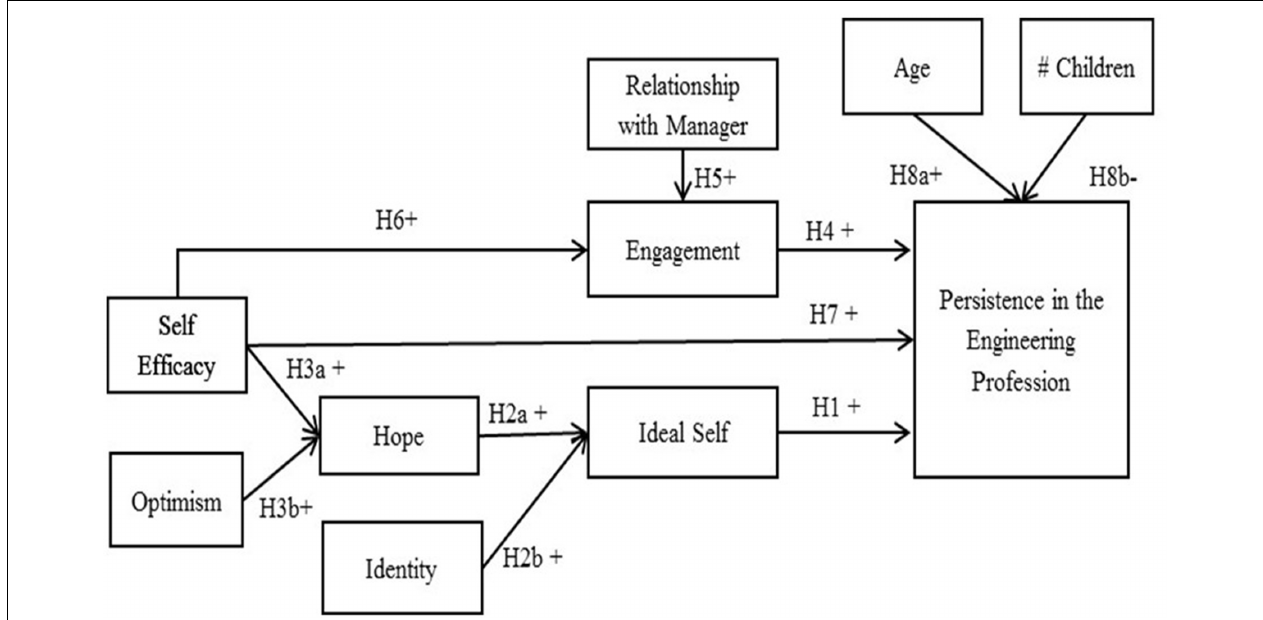
FIGURE 1 | Hypothesized model of factors impacting women’s persistence in